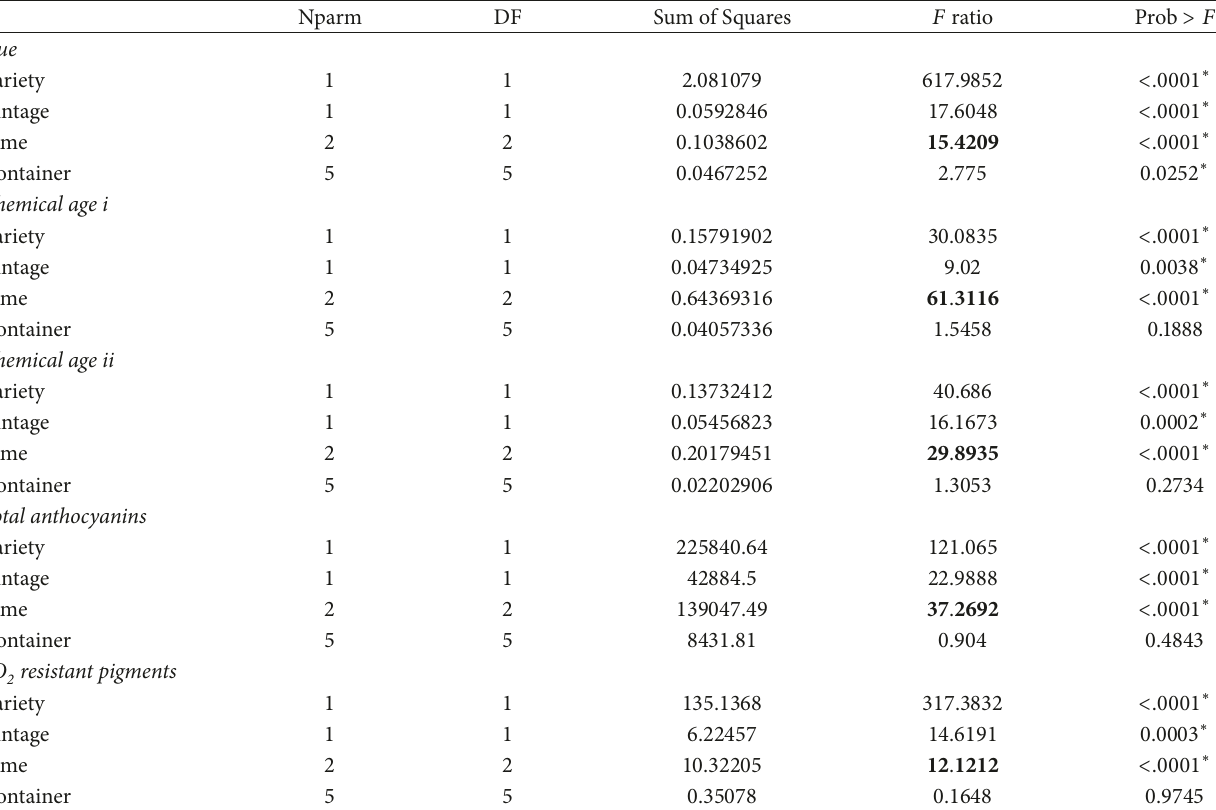
Table 3: Test results for fixed effects of hue, chemical age indexes i and ii, total anthocyanins, and SO 2 resistant pigments for Kotsifali and Mandilari wine